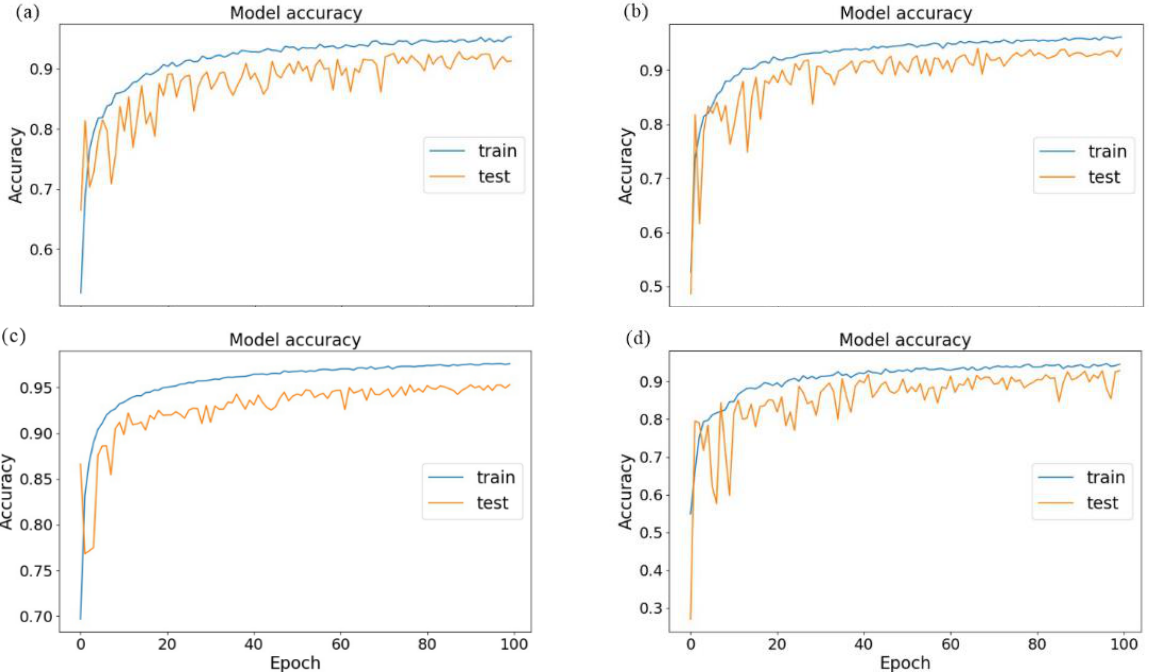
Figure 6. Model accuracy change curves: ( a ) batch size = 1; ( b ) batch size = 3; ( c ) batch size = 5; ( d ) batch size = 6.